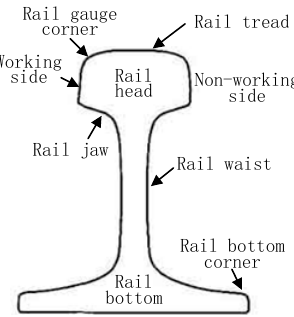
Figure 1. Schematic diagram of rail section.